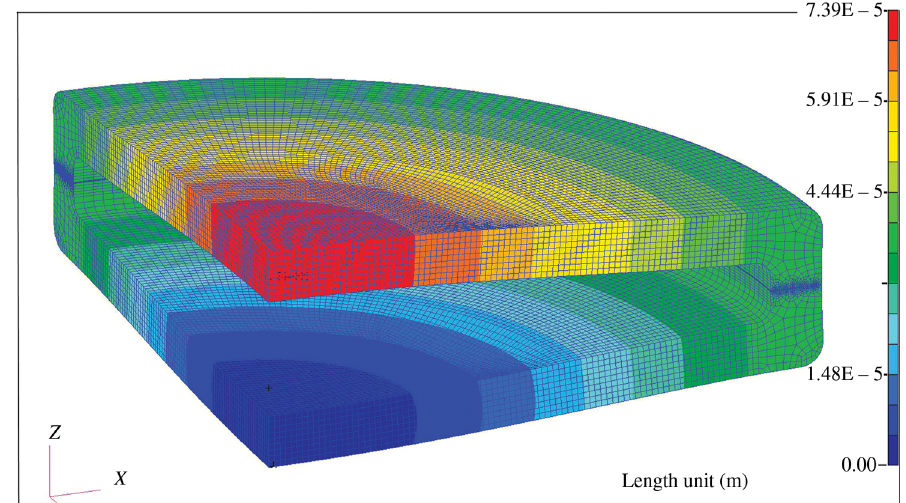
Figure 18: Primary mirror substrate design as a closed vase form with FEA Nastran code. All elements are hexahedra. Boundaries are expressed at the origin of displacements x = y = z = 0 and freedom along three radial directions in plane xy both at the back surface of the figure. Total axial displacement 69.2 μ m.